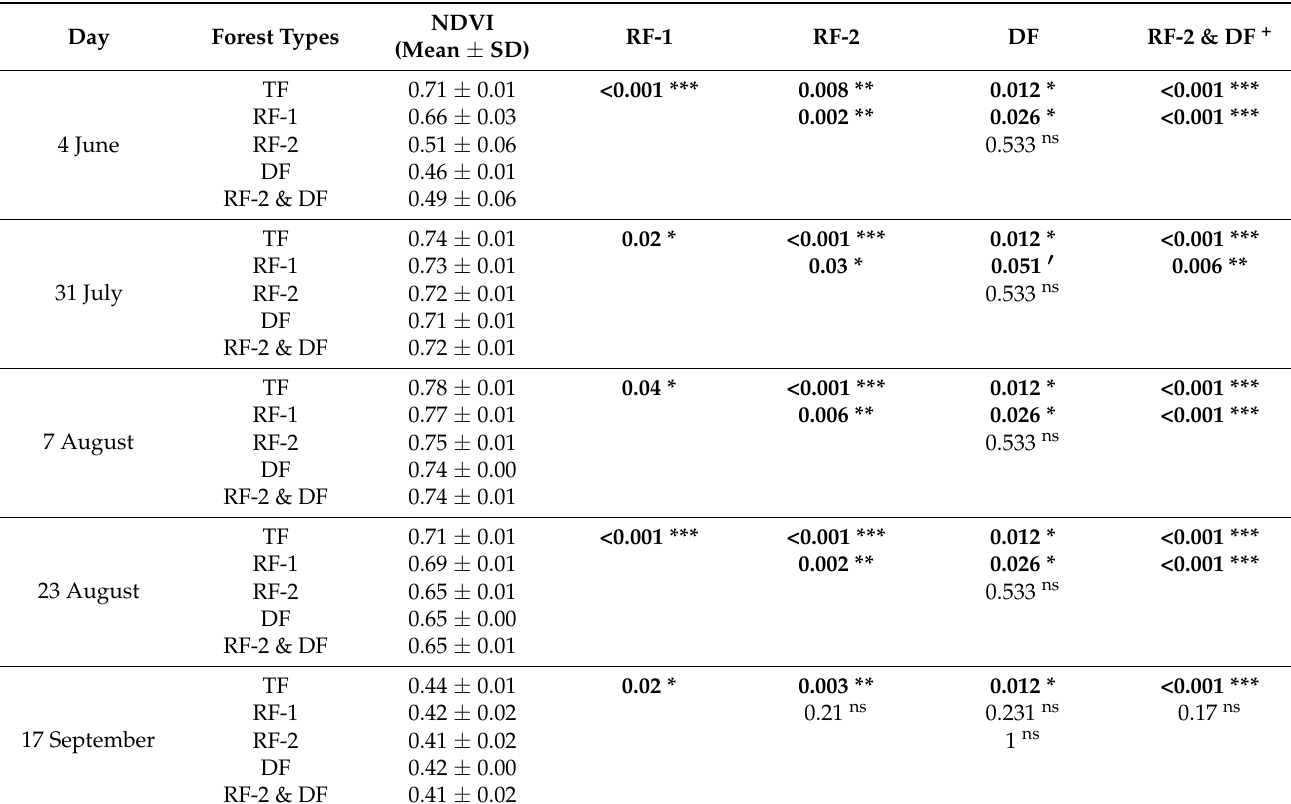
Table 1. Comparisons between the mean NDVI in two different forest types on 4 June, 31 July, 7 August, 23 August, and 17 September using two parametric unpaired two-sample tests, such as the classical Student’s equal variances t -test and the Welch unequal variances t -test, and one non- parametric Wilcoxon rank-sum test. The results of these three tests are presented as their significance values ( p